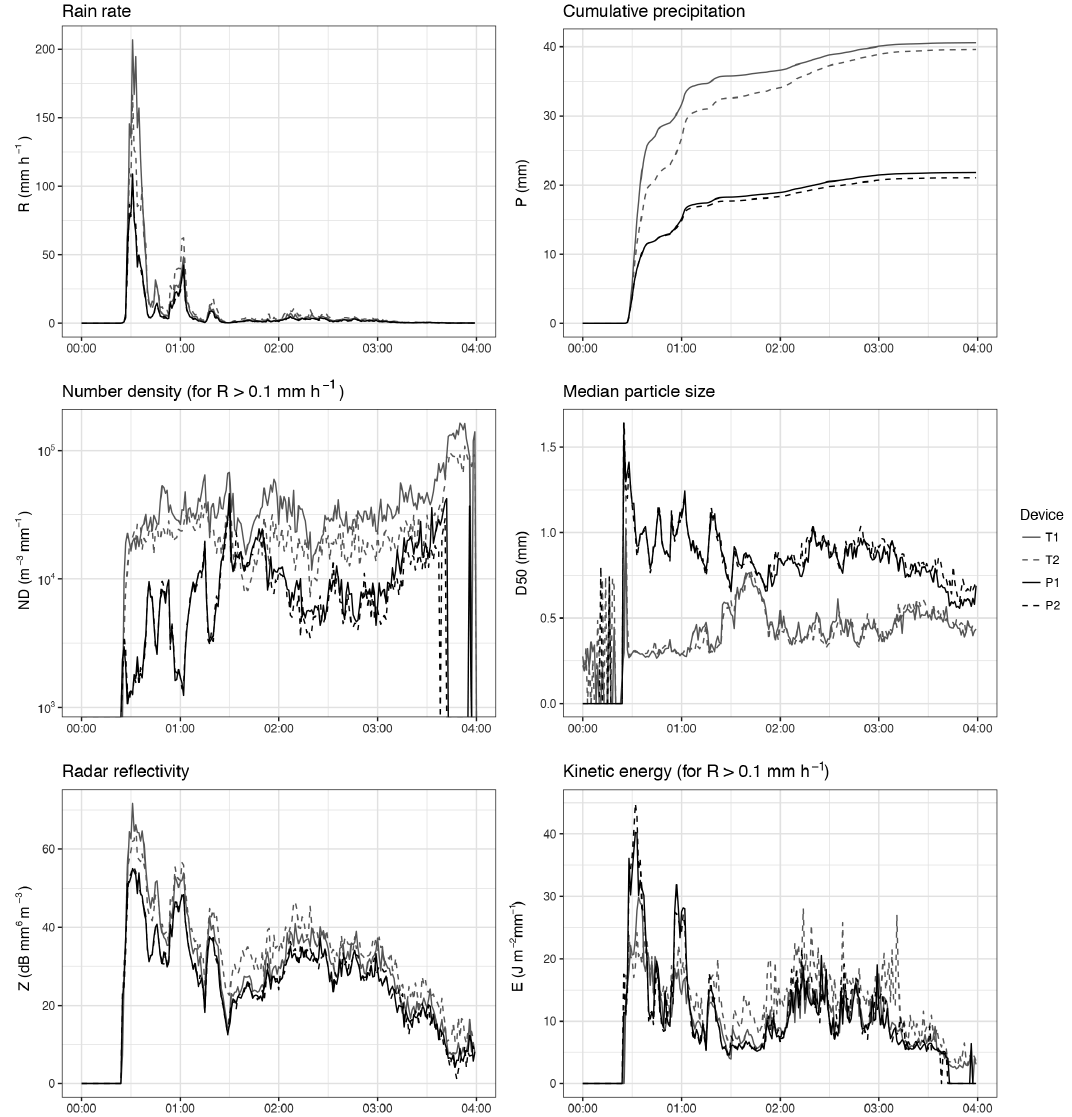
Figure A1. Time series of disdrometer bulk variables during a high-intensity event (E365), with no corrections of the PSVD